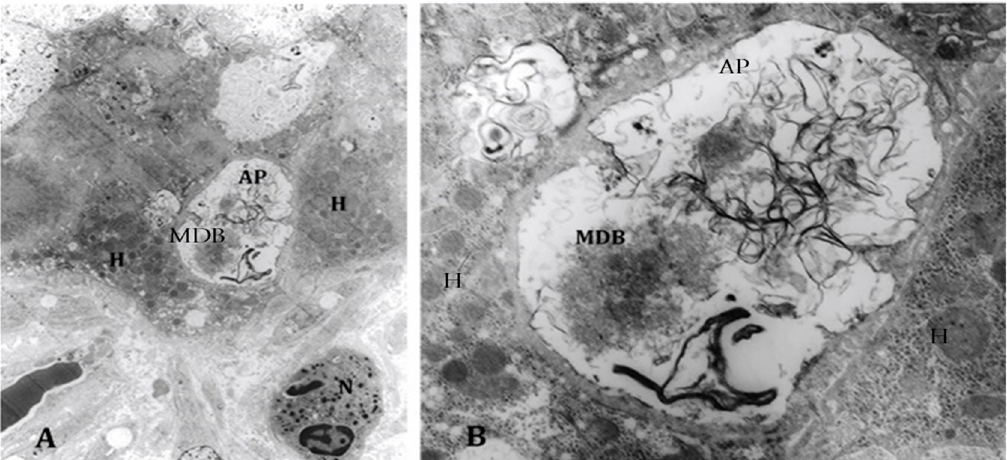
Figure 2. ( A ) Electron microscopy of an alcoholic steatohepatitis specimen showing an autophagosome (AP) adjacent to a neutrophil (N) and hepatocytes (H) (1458x); ( B ) higher magnification of the autophagosome shows a Mallory–Denk body (MDB) within it, mixed in with tangles of membranes (6250 × ). Previously published in [21].